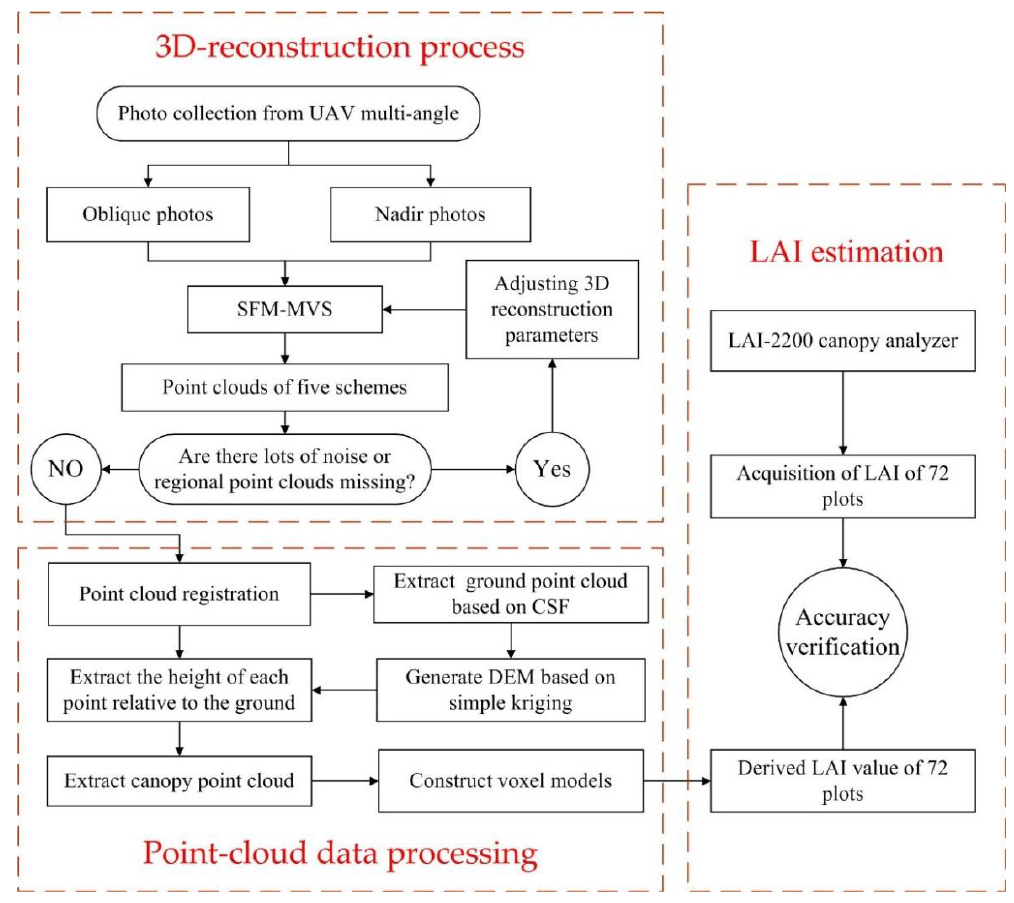
Figure 3. General workflow.